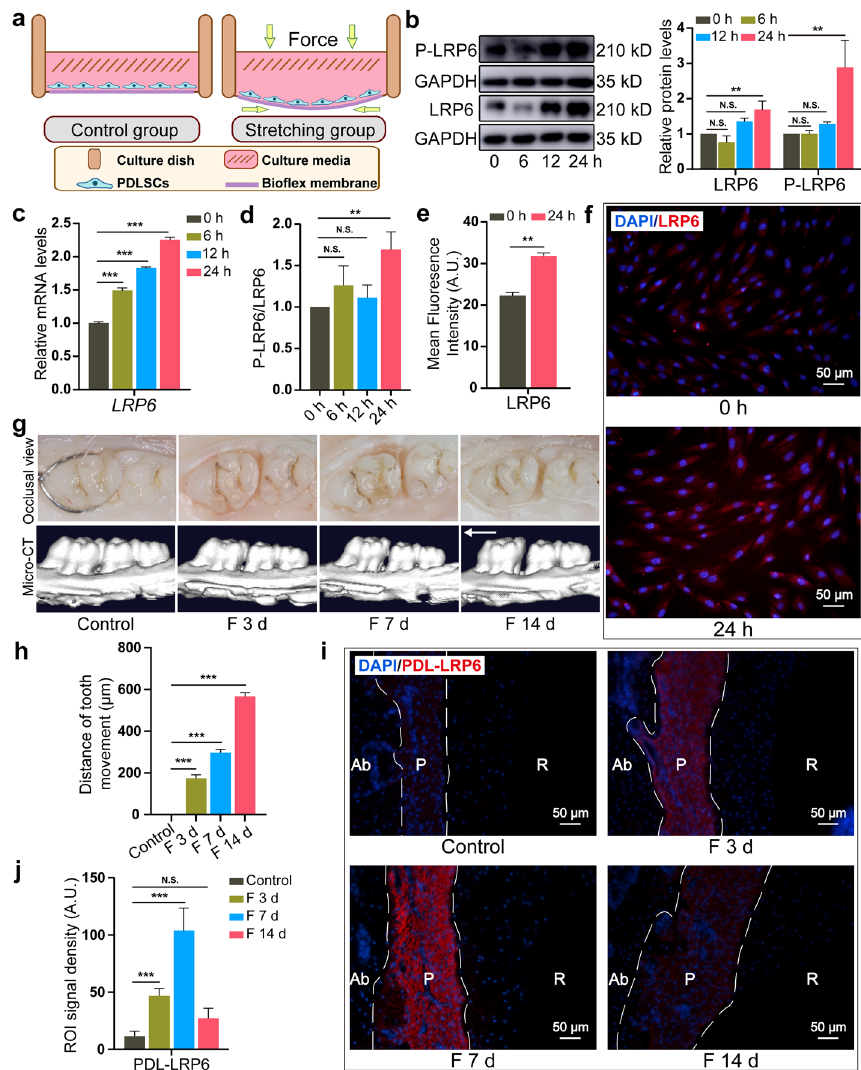
Fig. 1 Enhanced LRP6 expression in force-induced PDLSCs and PDL tissues. a Diagram of the in vitro cell tension-loading system. b The protein expression of LRP6 and P-LRP6 in PDLSCs during CSS loading. c The mRNA expression of LRP6 in PDLSCs during CSS loading. d The ratio of the protein levels of P-LRP6/ total LRP6 in PDLSCs during CSS loading. e , f Immunofluorescence and semi-quantitative analysis of LRP6 expression under CSS for 24 h. Scale bar, 50 μm. g Representative occlusal view and micro-computed tomography of OTM for 3, 7, and 14 days (F 3 d, F 7 d, F 14 d, N force loading. h Quantitative analysis of the change in the distance of OTM. N and semi-quantitative analysis of LRP6 expression in the periodontium during mechanical force application. N 5. Ab, alveolar bone; P, periodontal tissue; R, root. Dotted lines mark the boundary of the PDL. Scale bar, = 50 μm. * P < 0.05, ** P < 0.01, *** P < 0.001. N.S., no significance. Results are presented as mean